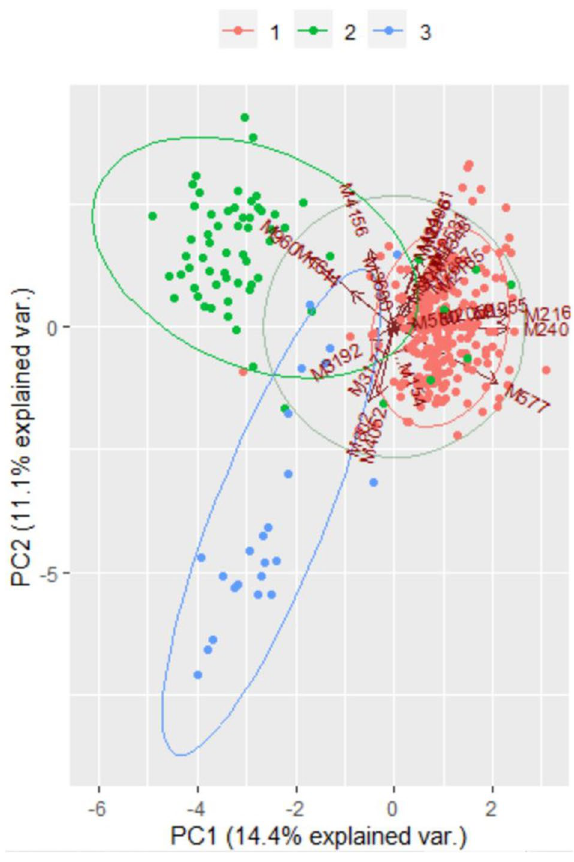
Figure 5. A Two-dimensional scatter plot of MTBC isolates from Sikkim, India based on principal component analysis. Based on eigenvalues, the first two components account for 14.4% and 11.1%, of the total variation